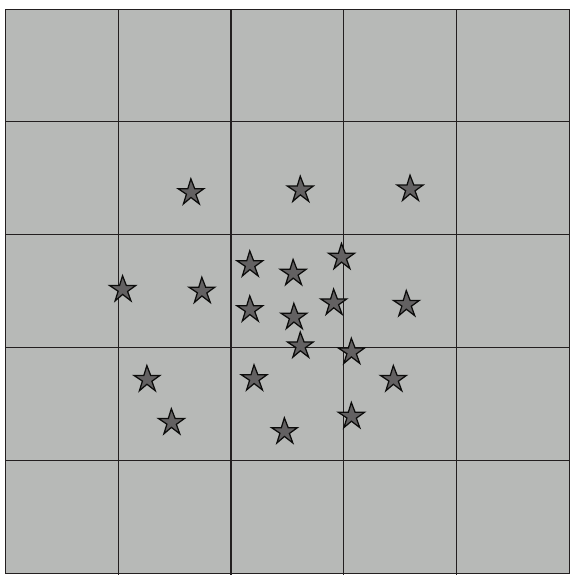
Figure 10: Test results of positioning accuracy filtering using the strong tracking